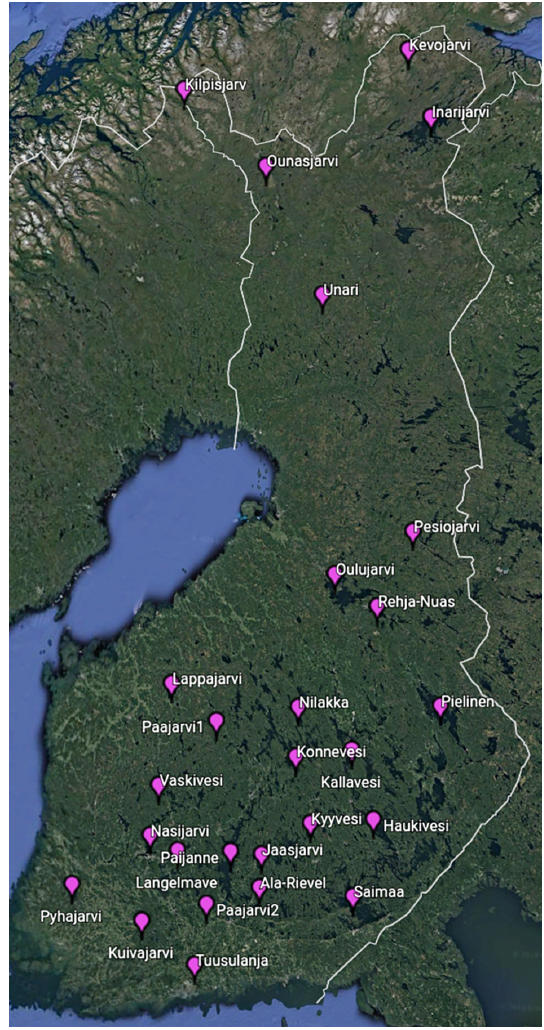
Figure 9. Locations of 27 lake verification sites (© Google Maps